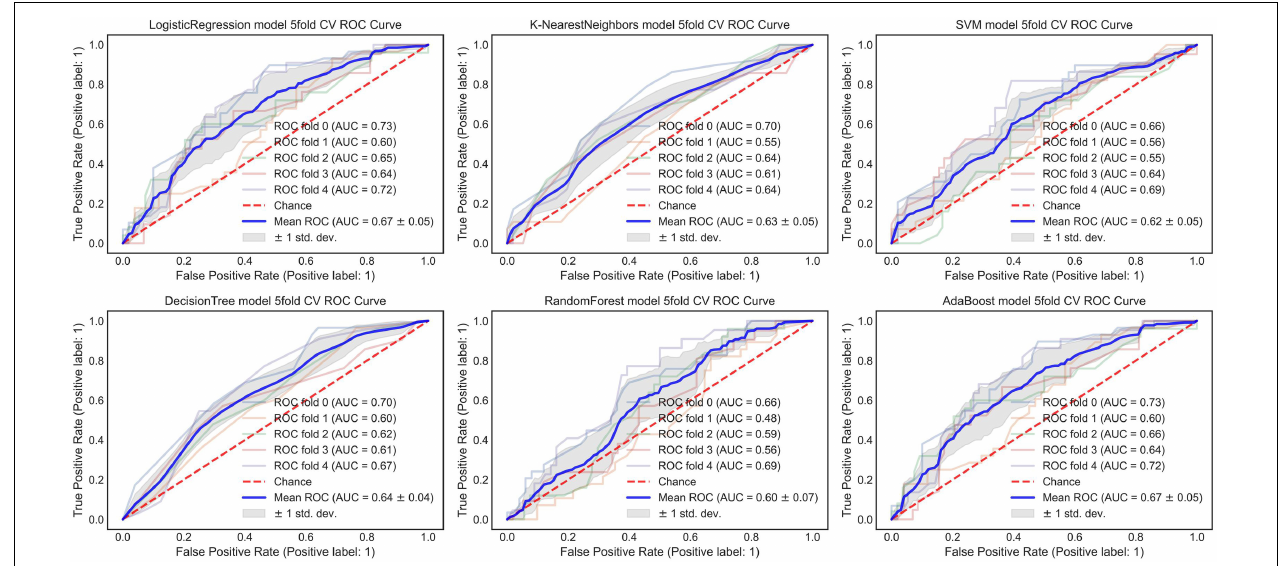
FIGURE 3 | The AUC of the optimized morphological feature model for predicting EVAR-related SAEs in the training set. AUC, area under the curve; SAEs, severe adverse events; EVAR, endovascular aneurysm repair.